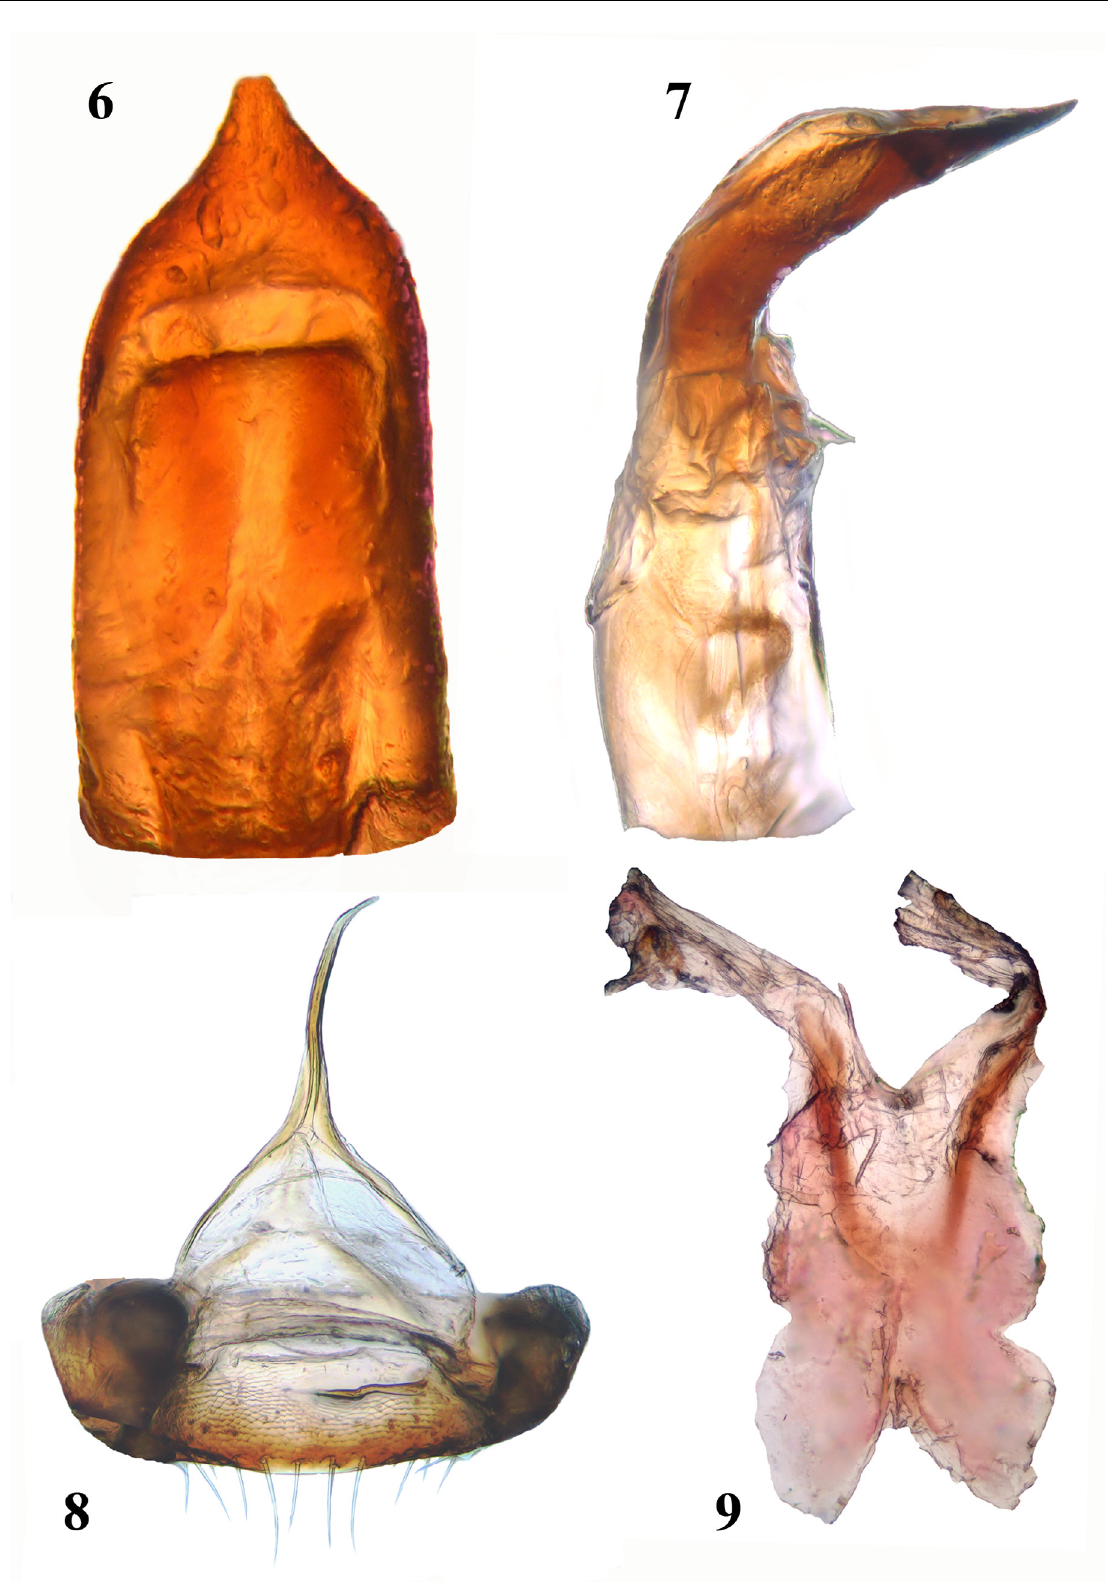
Figs 6–9. male genitalia of Fidia kanaraensis (Jacoby, 1895) comb. nov. 6 . Aedeagus, dorsal view. 7 . Aedeagus, lateral view. 8 . Tergite VIII, sternite VIII & IX. 9 .